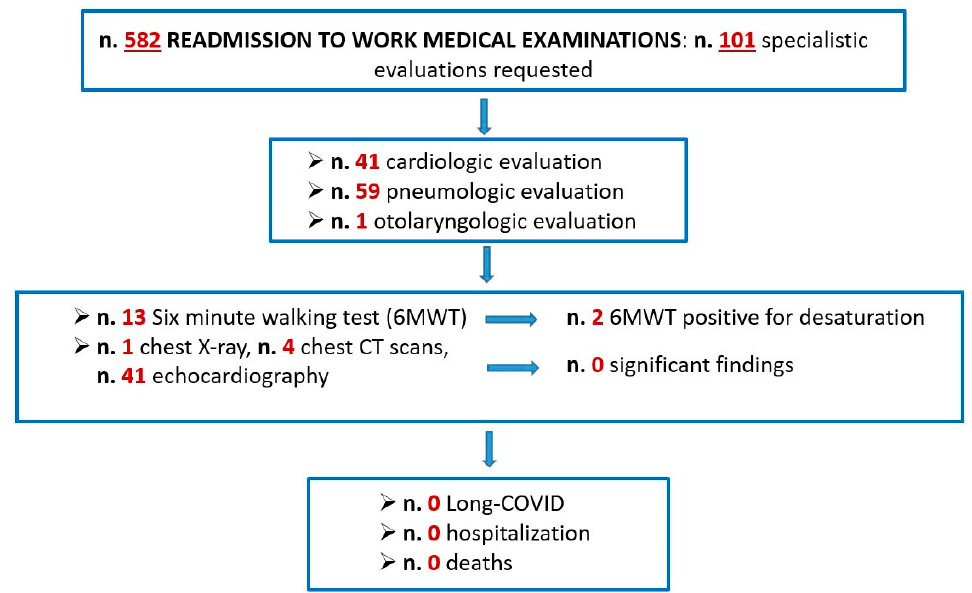
Figure 1. BI readmission to work and outcomes.